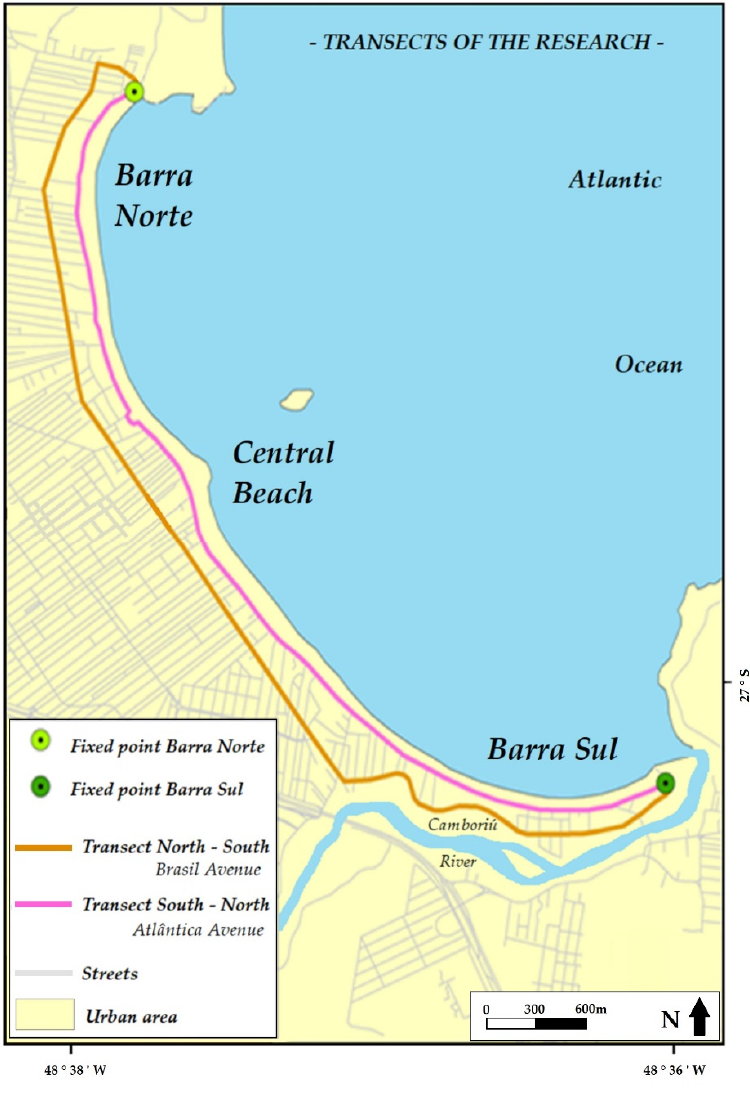
Figure 3. Map of the mobile transects carried out in the urban area of Balneário Camboriú/SC, on 26th August 2019, at 06:00:00 a.m.